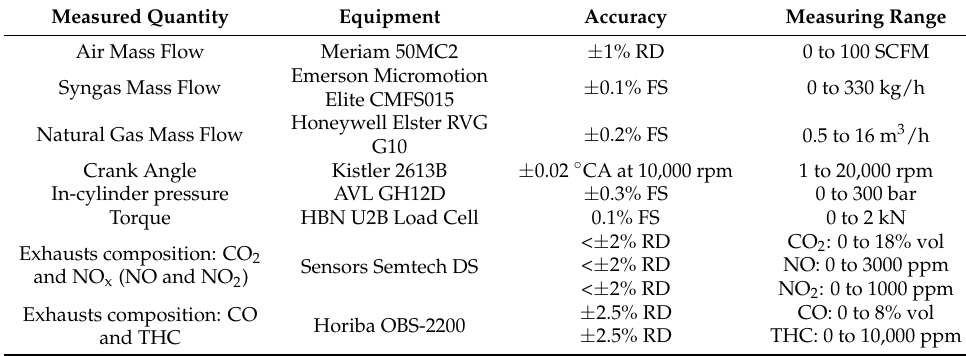
Figure 1. Scheme of the measurement system set-up. Table 4. Measurement system information 1 .